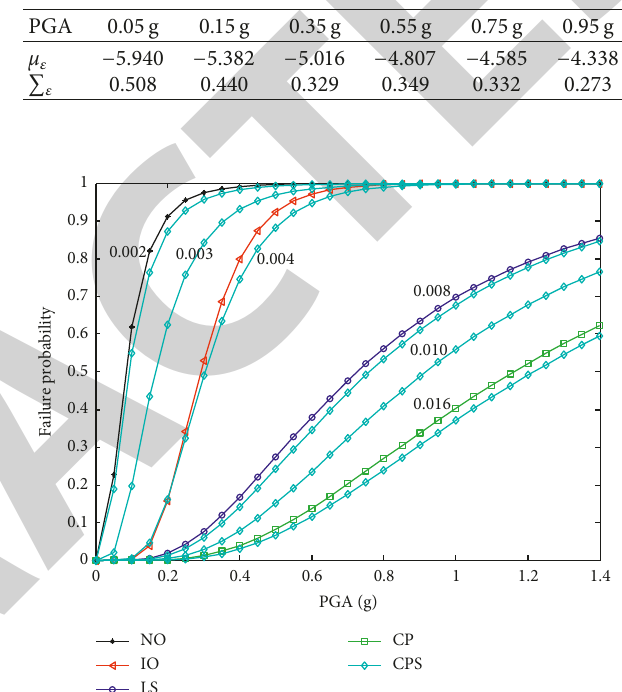
Table 3: Distribution parameters for maximum CPS.